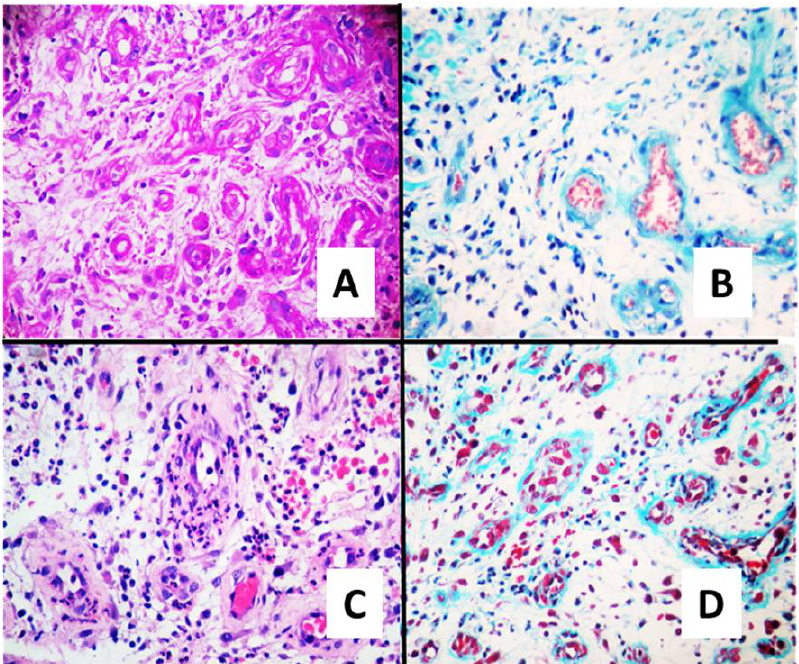
Figure 2. Histopathological analysis of wound healing at day 21 of treatment. Representative microscope photographs of ulcers in each treatment group are shown. Haematoxylin-eosin staining ( A , C ) and Masson’s trichrome staining ( B , D ) shows that SuDe + Lp treatment ( C , D ) induced an abundant synthesis of ECM, and its accumulation in healed ulcers is evident when compared to SuDe ( A , B ). In addition, the ordered deposition of collagens is clear. Photos were taken with 40 × objective. Parameters based on CD34 staining are in concordance with the acceleration of gran- ulation tissue production characterised by active fibroplasia and angiogenic sprouting (Figure 3 and Table 2).